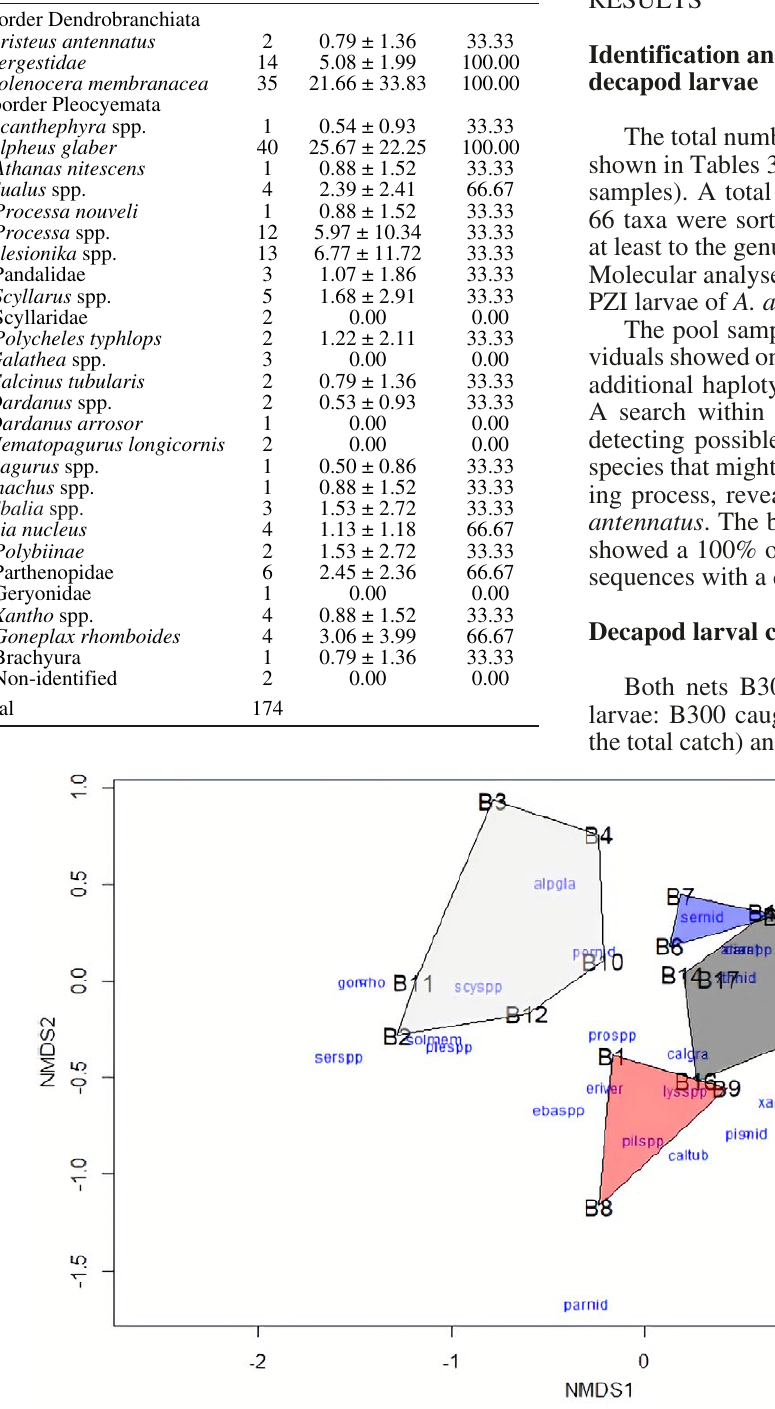
Table 4. – Total number (N) of decapod larvae caught with MOC- NESS sampler. Taxon